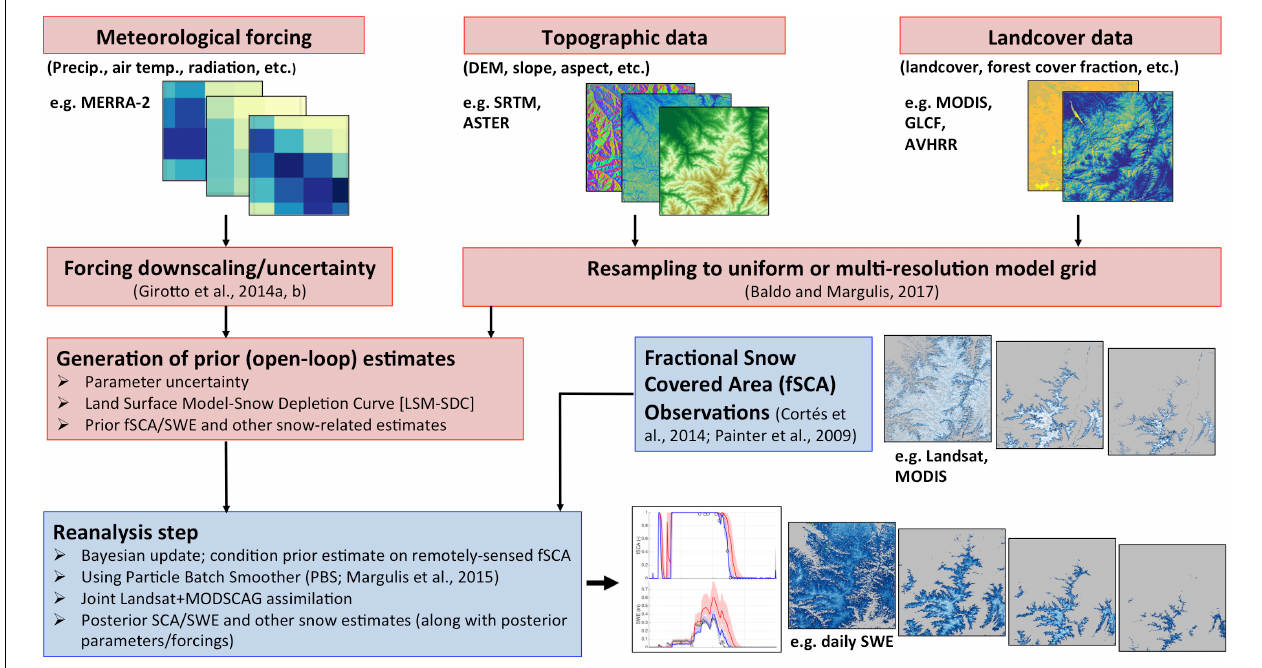
FIGURE 2 | Schematic representation of the Bayesian snow reanalysis framework that consists of an ensemble-based prior modeling system (red boxes) and a posterior update component for assimilating remotely sensed fractional snow covered area (SCA) data from Landsat and MODIS (blue boxes).